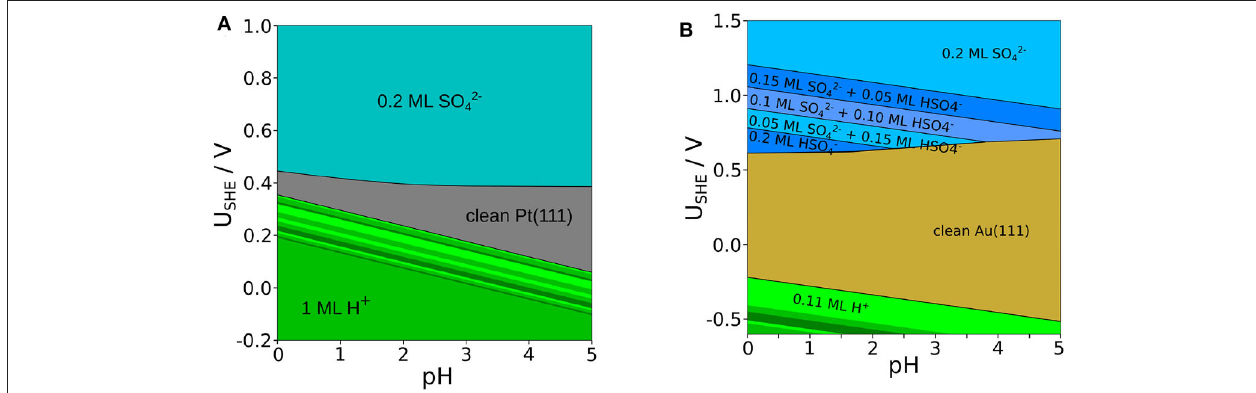
298 K and a fixed sulfate activity of =